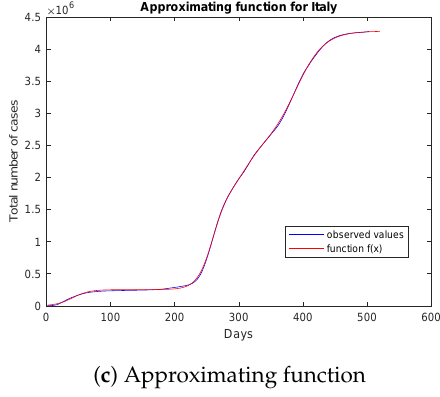
Figure 3. Scalograms and the approximating multilogistic function (24) for